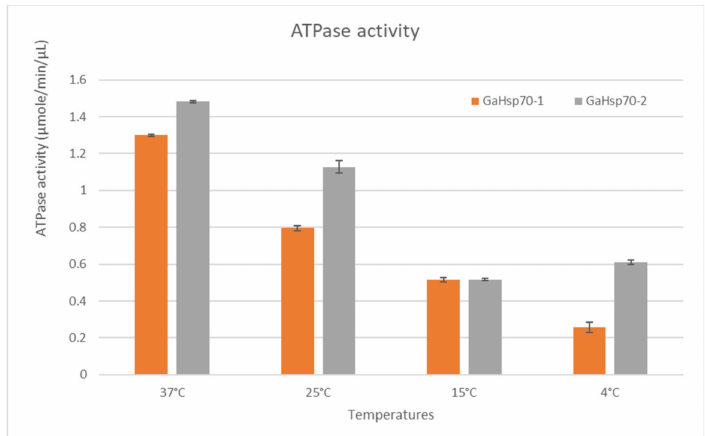
Figure 3. ATPase hydrolysis activity at different